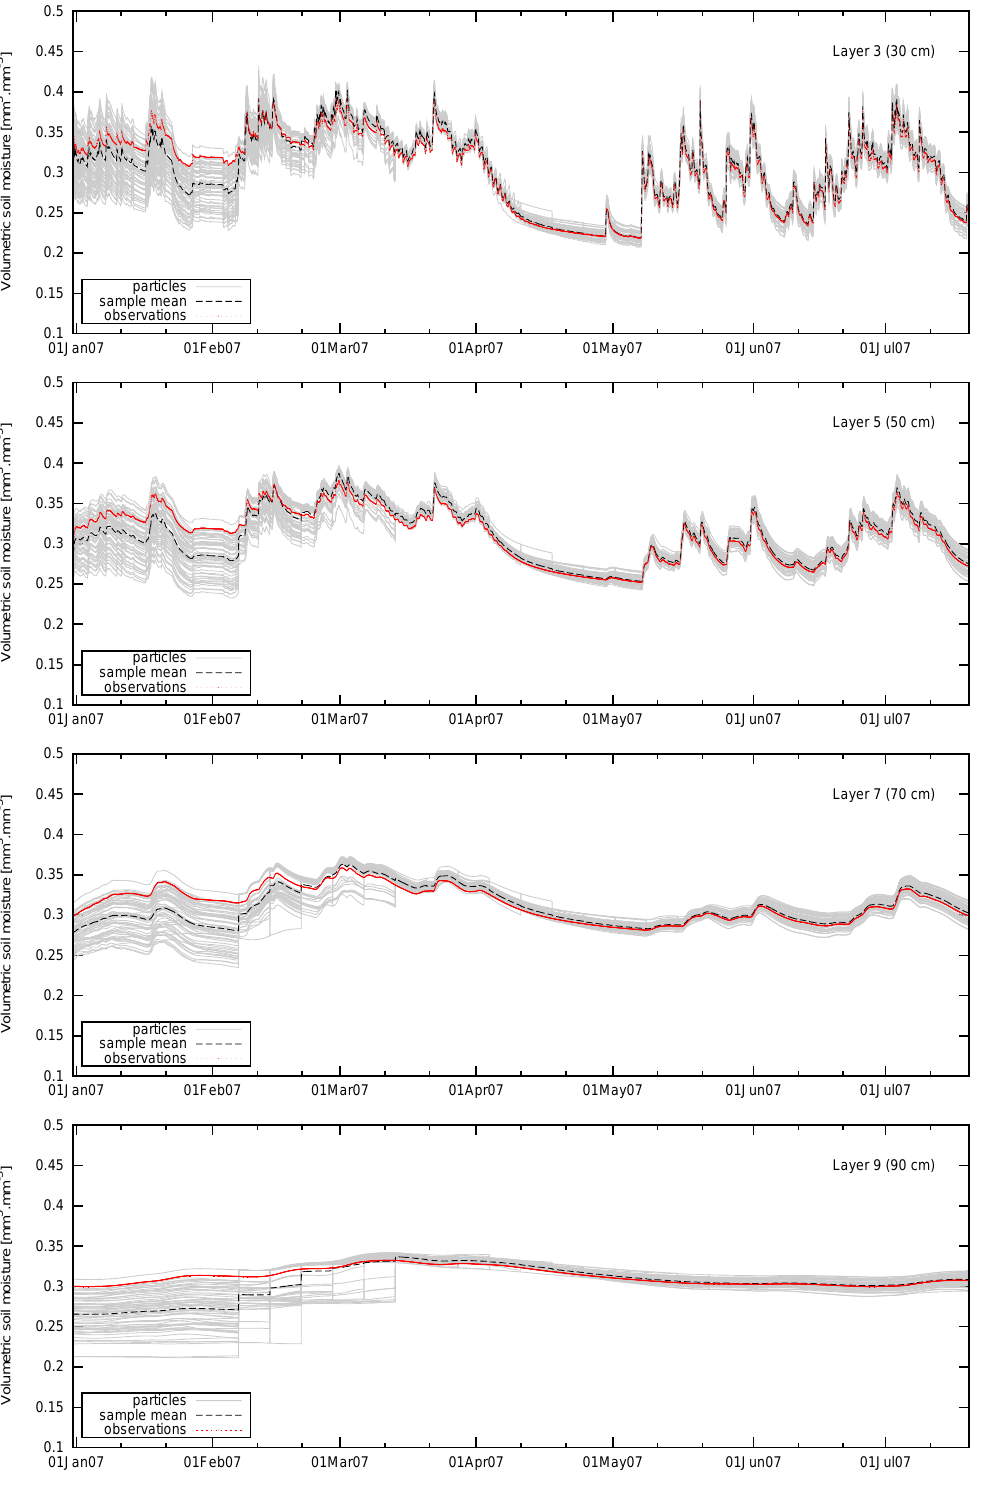
Fig. 8. Impact of the assimilation of soil moisture in the top layer on the bottom layers when the SISR-PR filter is applied with parameter perturbation.